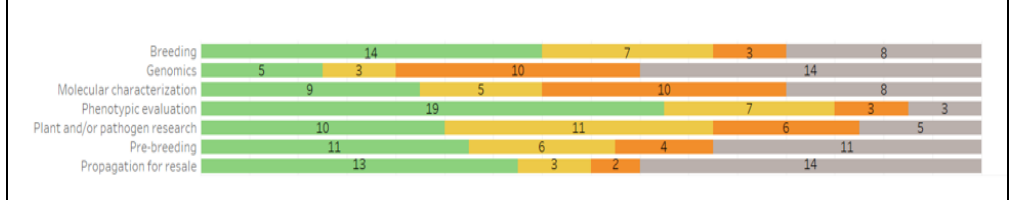
Figure 7. The number of collections that use materials on-site for listed purposes, and the frequency of those uses (frequent: green; moderate: yellow; rare: orange; never: gray). Most collections use the IPGRI Citrus descriptors for standardized phenotyping [35]. Citrus collections have been genotyped using a wide range of markers